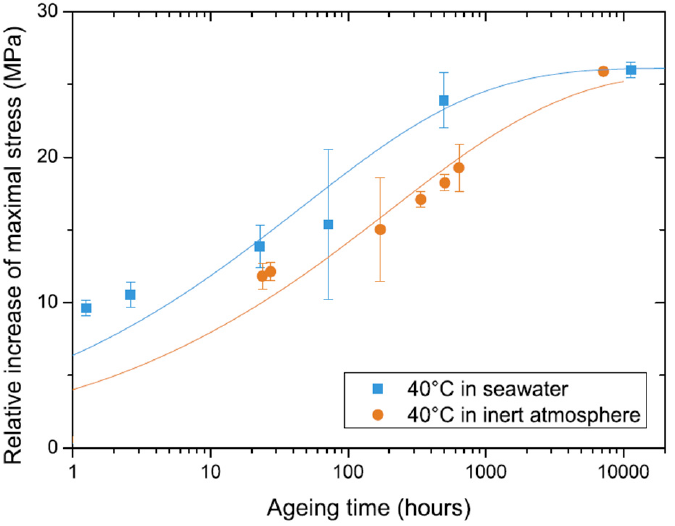
Figure 6. Strength vs. ageing time for amine-based epoxy conditioned in seawater up to saturation (wet) and in an inert atmosphere (dry). Adopted with permission from Ref. [96]. Copyright 2019 Elsevier.